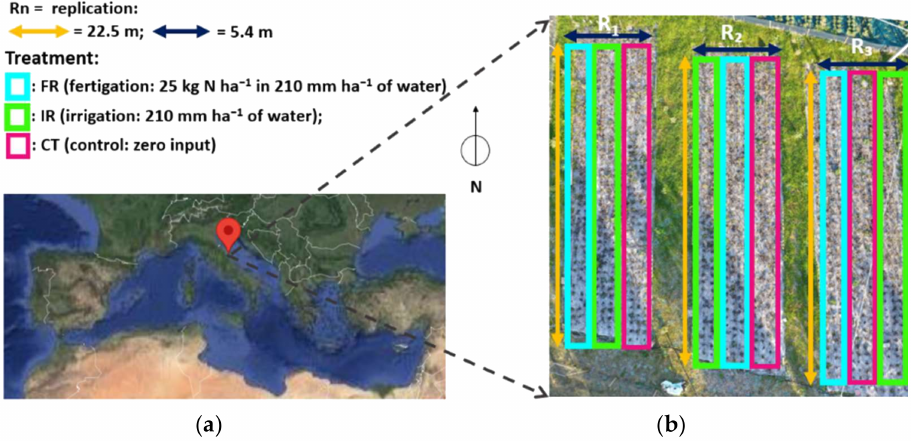
Figure 1. Experiment location ( a ) and planting design ( b ). Each replication had a size of 120 m 2 , with each plot consisting of 40 m 2 ; the planting pattern adopted was 0.45 m × 0.45 m, with a density of 9.8 plants m − 2 , corresponding to 98,000 plants ha − 1